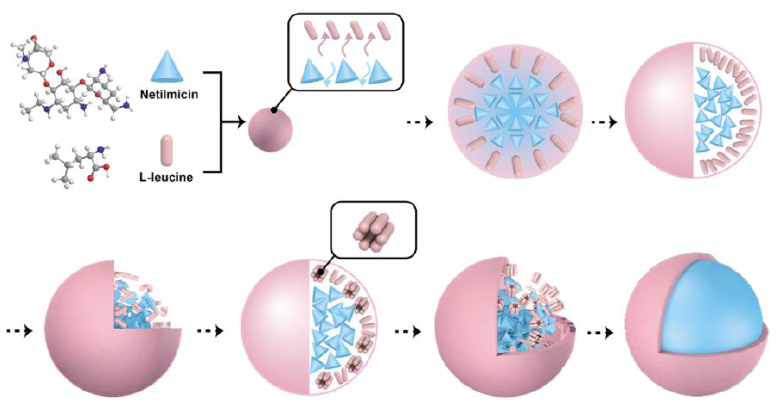
Figure 4. Schematic illustration of the formation mechanism of NTM DPIs.